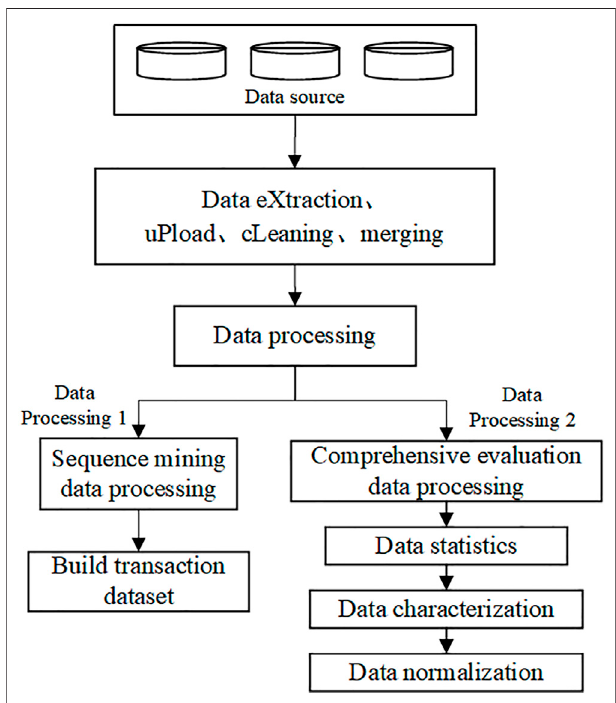
FIGURE 1 | Work ticket data preprocessing